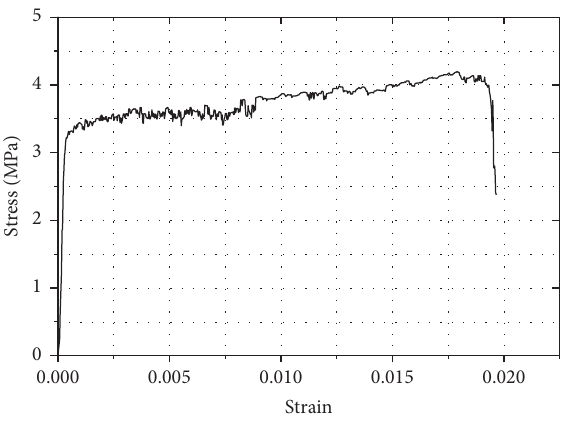
Figure 8: Stress-strain curve for ECC in uniaxial stress state in tension.